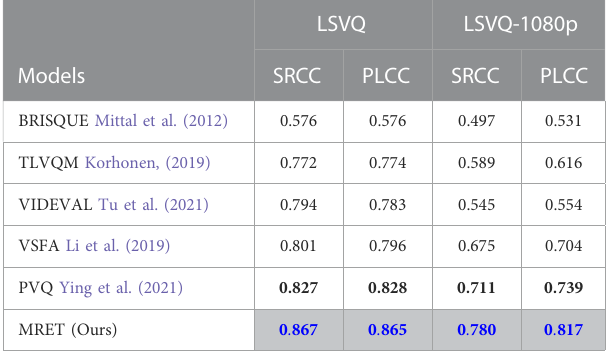
TABLE1Resultsonfull-size videosinLSVQandLSVQ-1080ptestsets.Blue and black numbers in bold represent the best and second best respectively. We take numbers from (Ying et al., 2021) for the results of the reference methods. Our fi nal method is marked in gray.